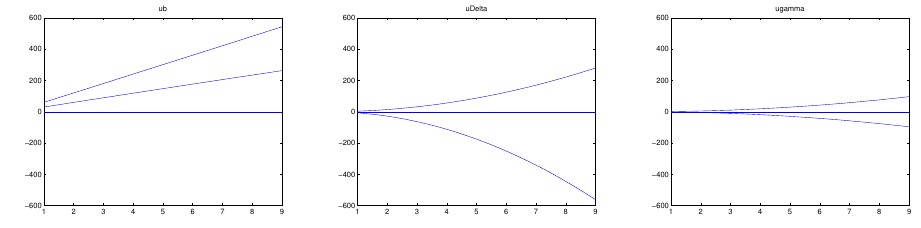
Fig. 18 Sensitivity of u with respect (left to right) the parameters b , ∆ and γ